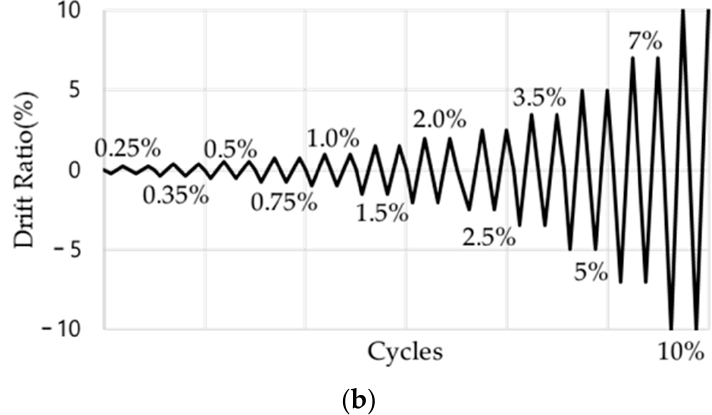
Figure 5. Test setup and loading protocol. ( a ) Test setup. ( b ) Loading protocol.